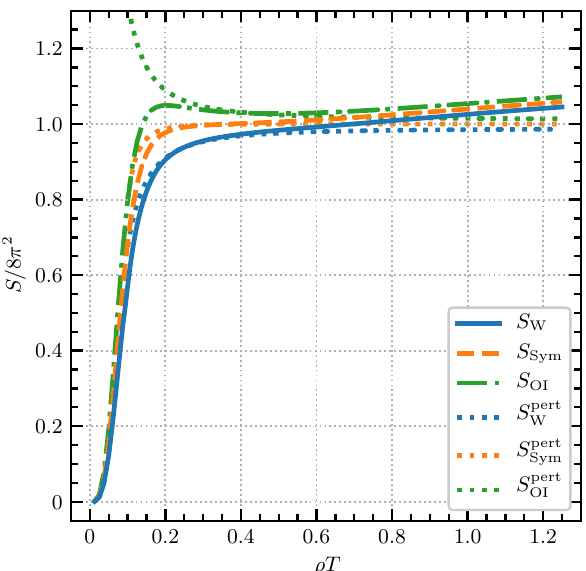
Fig. 1 Different actions together with the perturbative predictions as a function of the caloron size. The caloron is placed at the center of an 8 × 48 3 lattice. In this plot we used t 0 T 2 = 20 / 64 for reducing the boundary effects(cf.App. A). Dottedlinesindicateasmall- a expansion up to the first nontrivial